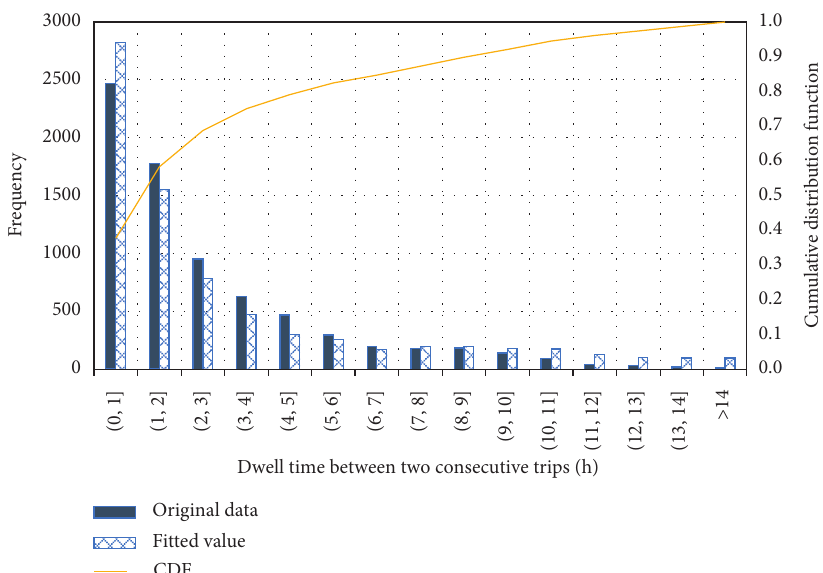
Figure 4: The distribution of dwell time between two consecutive trips.